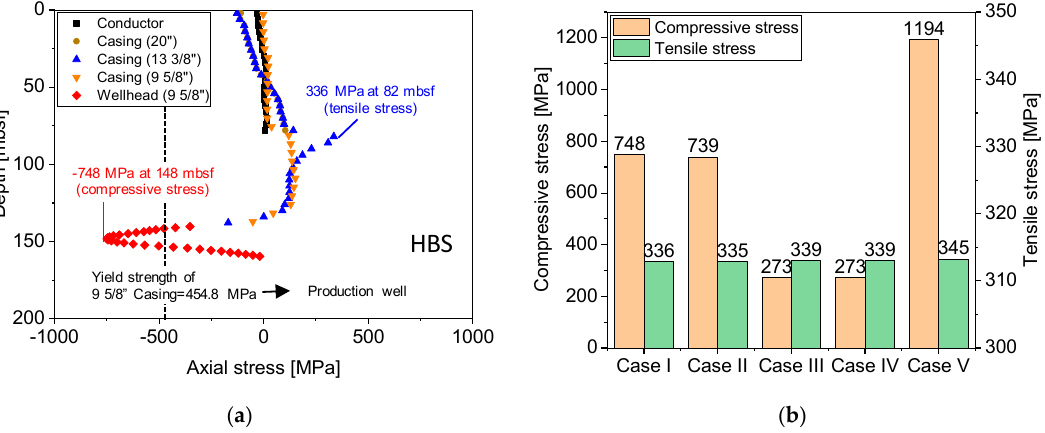
Figure 12. Distribution of axial stresses with depth (non-consideration of the slippage at the interface): ( a ) Distribution of axial stress with depth for case I; ( b ) comparison of the maximum compressive and tensile stress.